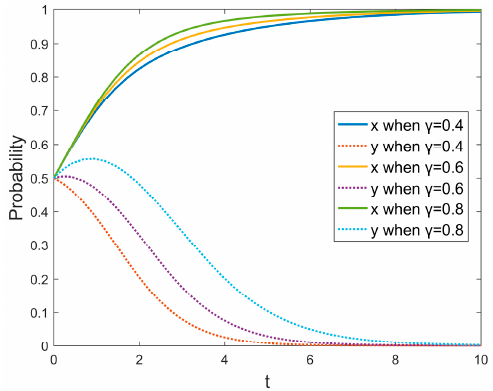
Figure 3. The impact of the poverty levels of herders in the evolutionary game